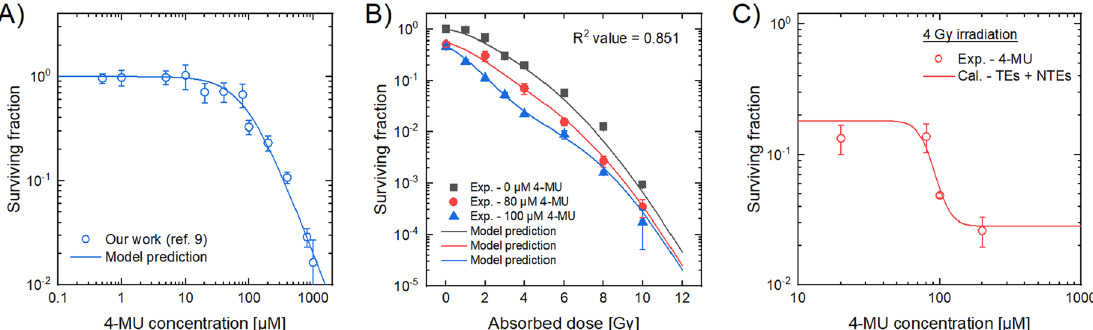
Figure 2. The cell surviving fraction estimated by the model. ( A ) The dose–response curve for 4-MU concentration of HT1080 cells. Blue solid line represents the survival fraction estimated by the log-logistic model (Eq. (1)), blue circle represents the experimental surviving fraction 9 . ( B ) The surviving fraction as a function of absorbed dose. R 2 value was calculated using Eq. (7). Charcoal line, red line and blue line represent the model prediction for the 0, 80 and 100 μM 4-MU cases, respectively. ( C ) The cell survival curve as a function of 4-MU concentration with a constant 4 Gy irradiation. Red line represents the IMK model prediction and red circles denote experimental data.